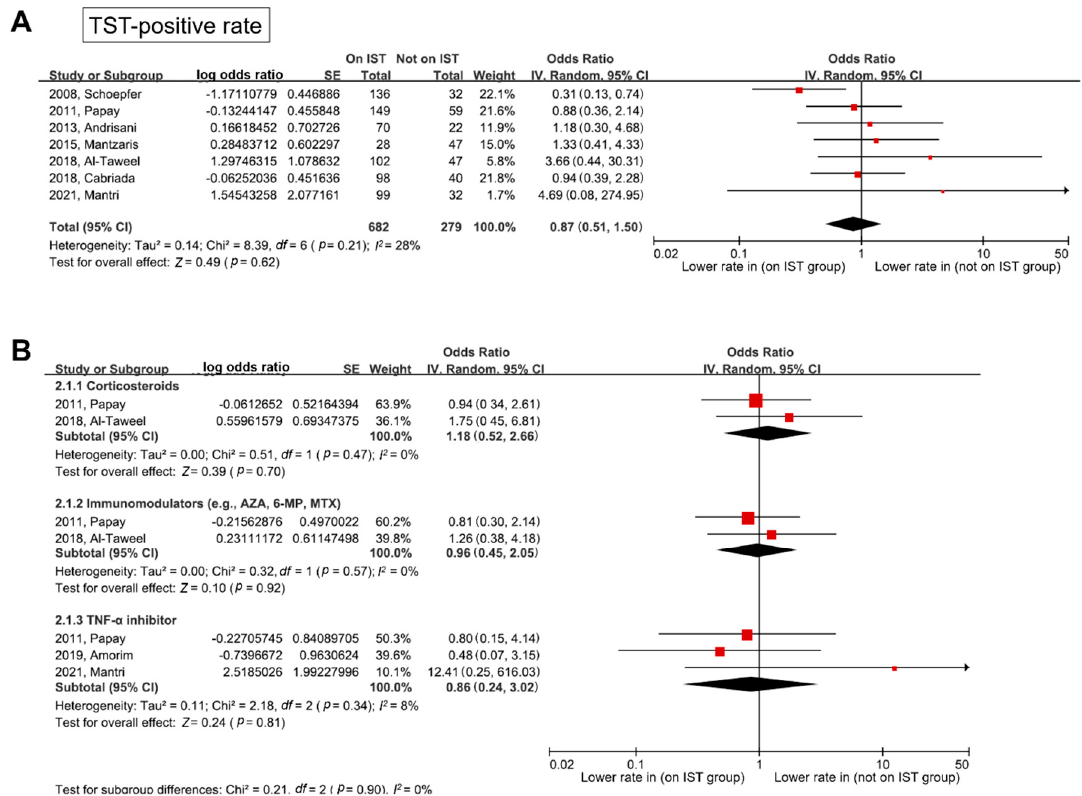
Figure 3. Forest plot for TST-positive rate between patients on IST and those not on IST. ( A ) Any IST, and ( B ) subgroup analysis according to IST. These analyses only included studies that used different cutoff values depending on TB risk according to the current guidelines (e.g., 5 mm for patients on IST (or high-risk patients for TB), and 10 mm for patients who were not on IST (or low-risk patients for TB)) [15]. TST—tuberculin skin test; IST—immunosuppressive treatment; TB—tuberculosis; AZA—